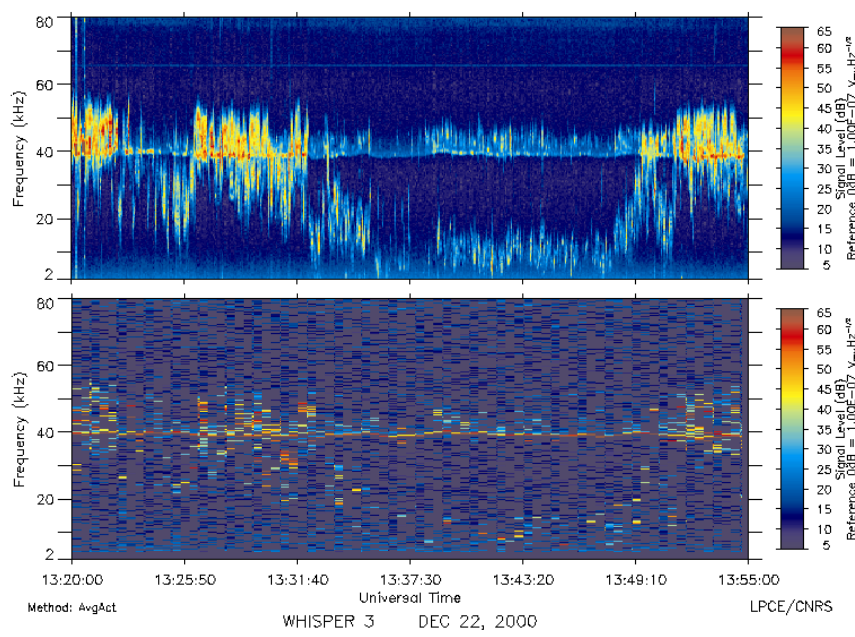
Fig. 10. Frequency/time spectrogram in Natural wave mode only (upper panel) and in Sounding mode only (lower panel) measured by SAMBA (spacecraft 3) in the foreshock region (22 December 2000).